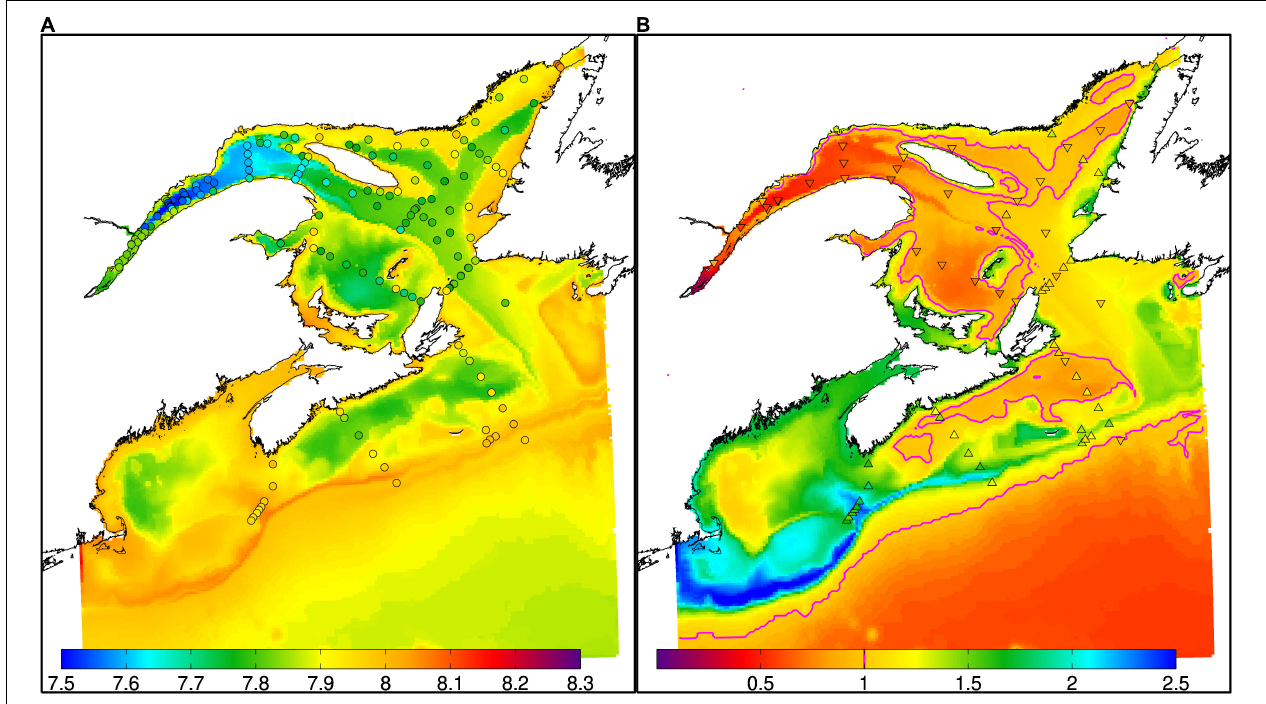
FIGURE 12 | Simulated (background color) and observed (circles) bottom pH (A) and (triangles) aragonite saturation states (B) in October-November of 2014. The magenta line in panel B delimits the areas where simulated saturation states are below one. The upward-facing triangles indicate observed values above one, while the downward-facing triangle indicate that the observed values are below